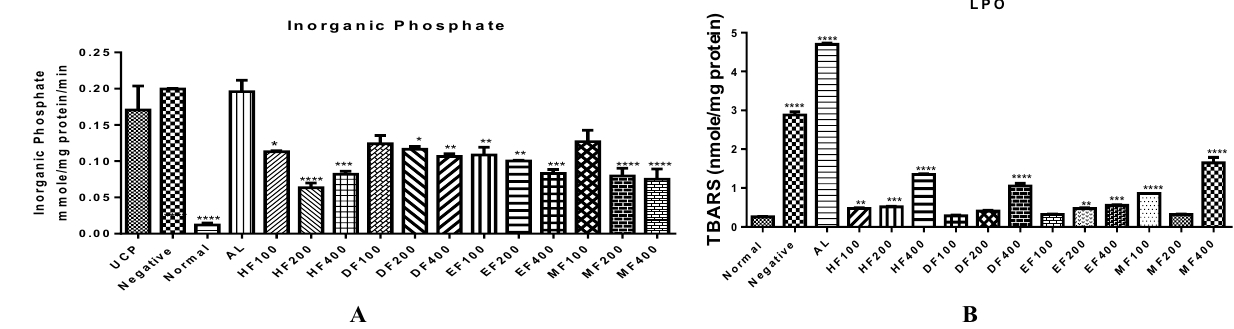
Figure 3. The ATPase activity of mitochondria isolated from the liver of experimental mice and mitochondrial lipid peroxidation results are presented in ( A , B ), respectively. Both infected control and control drug (Artemether lumefantrine) significantly ( P < 0.001) enhanced ATPase activity while fractions of Diospyros mespiliformis significantly ( P < 0.001) decreased ATPase activity ( A ). In ( B ), only DF 100, 200 mg/kg DF and 100 mg/kg EF were not significantly different from the normal control. The lipid peroxidation values of all groups were significantly lower than the negative